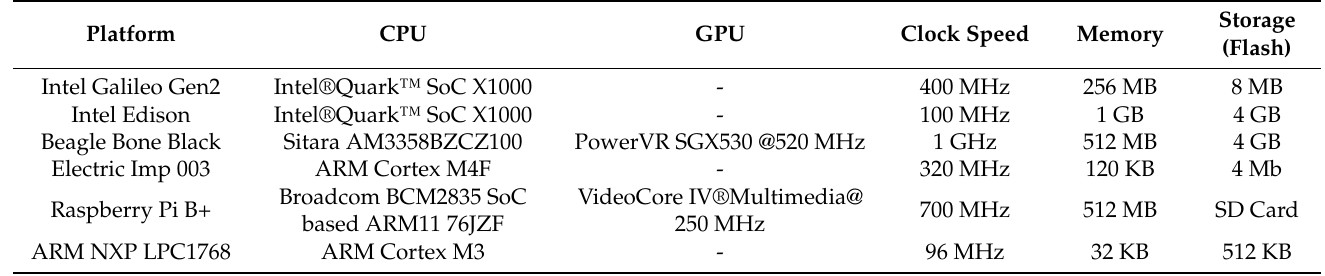
Table 2. Comparison of the existing internet of things (IoT) supported hardware platforms